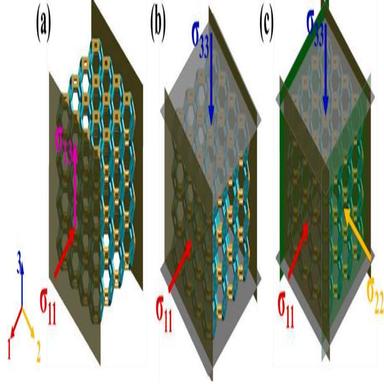
FEMs under multiaxial loading conditions in the 1–3 plane: (a) compression-shear; (b) biaxial compression; and (c) triaxial compression.